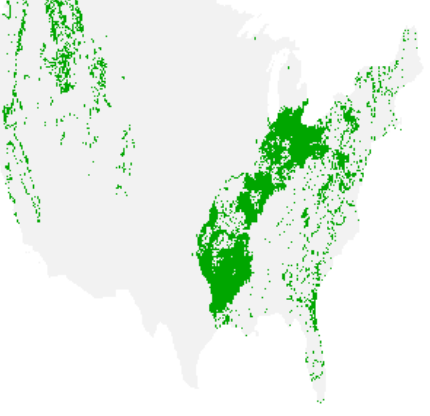
Figure 7. Rotation pattern of US mainland precipitation The following two maps show the result of two types of deformation. The first map describes clockwise direction, and the second map shows anticlockwise direction. In general, this deformation is very weak, and all deformation areas are surrounding the previous precipitation areas. There